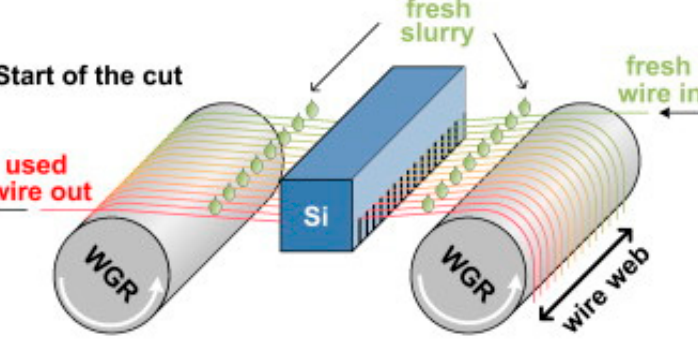
Figure 1. Schematic diagram of the working principle of a multi-wire saw for a saw steel wire. Reprinted with permission from ref. [1].